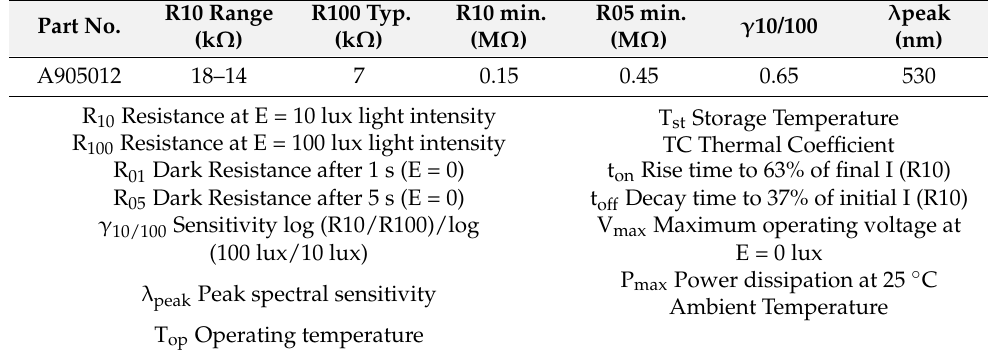
Table 3. CdS photoresistor specification. Part